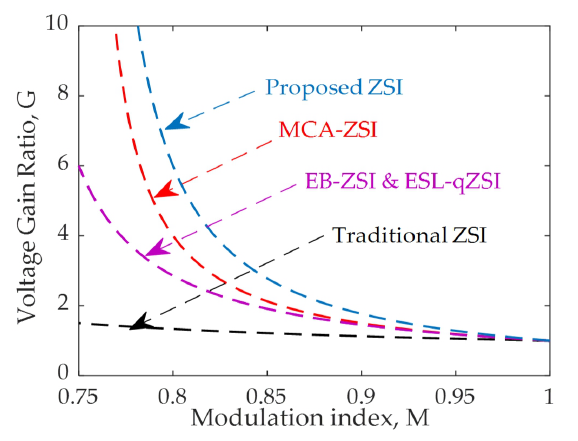
Figure 7. Characteristic curve: modulation index vs. voltage